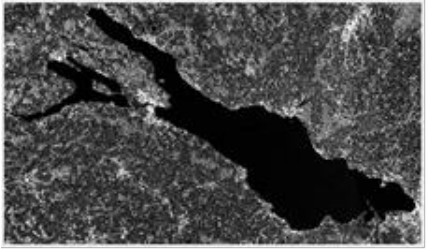
Figure 6. Used SAR data (after pre-processing)